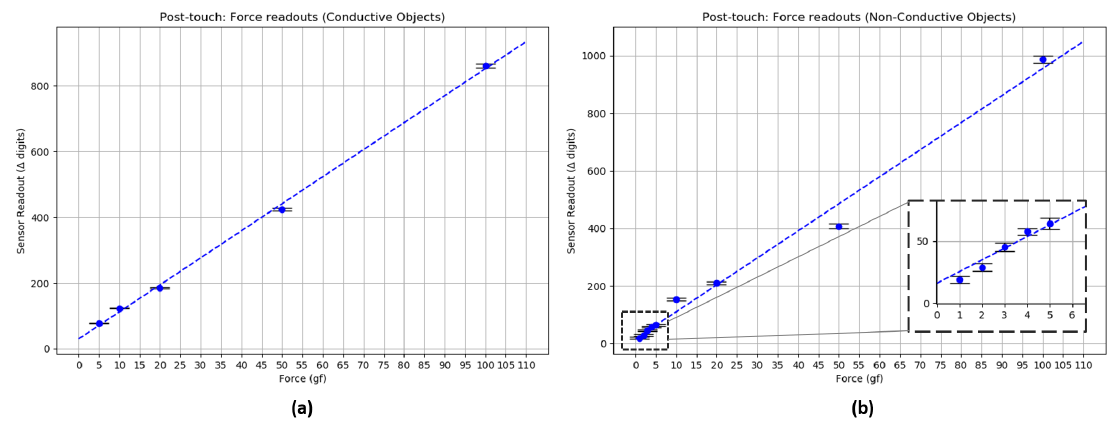
Figure 18. Capacitive normal force sensing: “post-touch” experiment results. ( a ) Conductive objects (steel). ( b ) Non-Conductive objects (dry uncooked rice), with inlay details for small weight values of 1–5